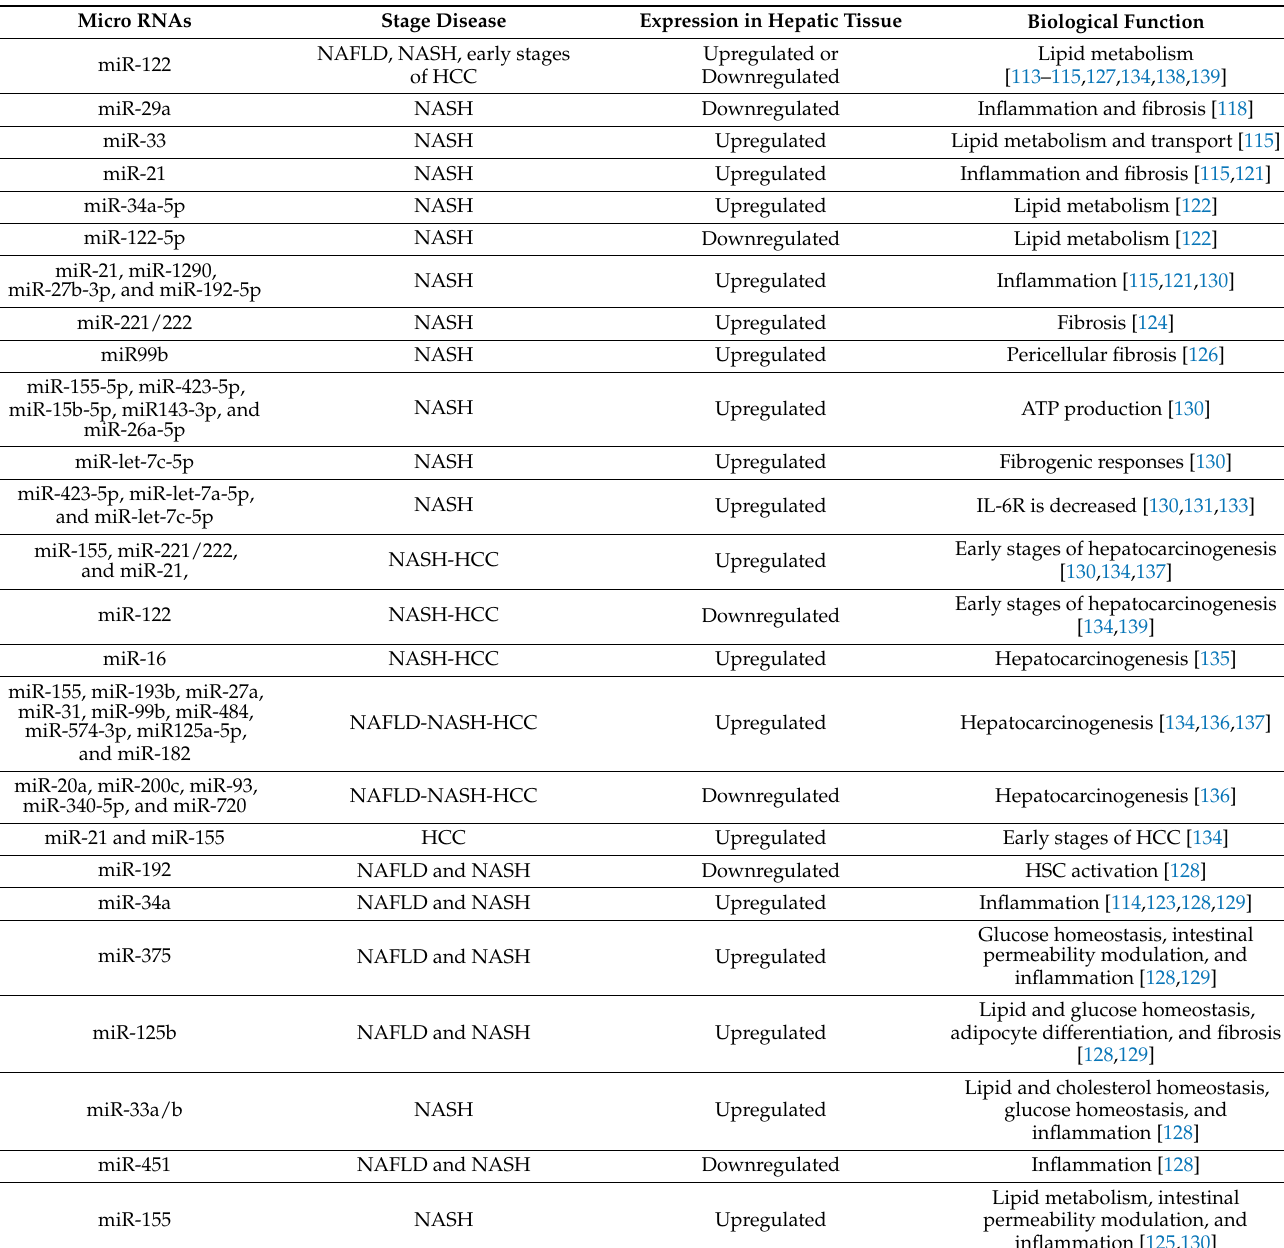
Table 2. Micro RNAs dysregulated in NASH and